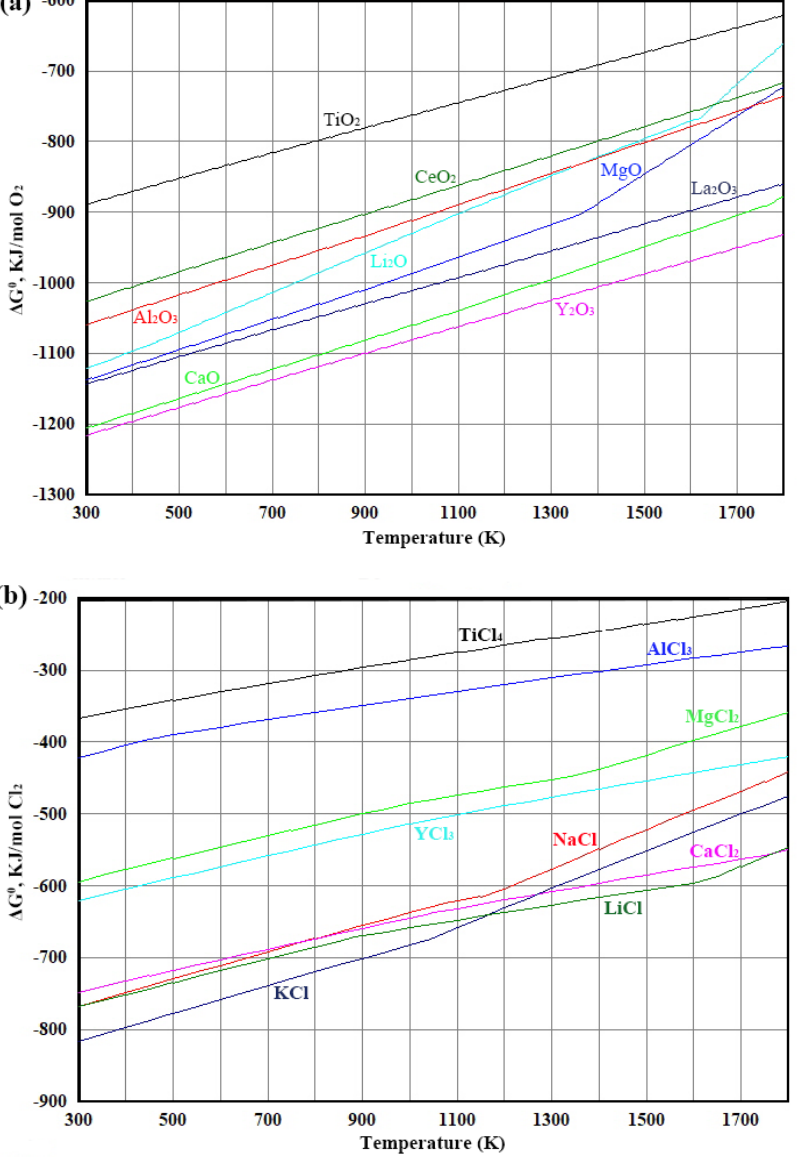
Figure 1. ( a ) Ellingham diagrams for the formation of oxides; ( b ) Ellingham diagrams for the formation of